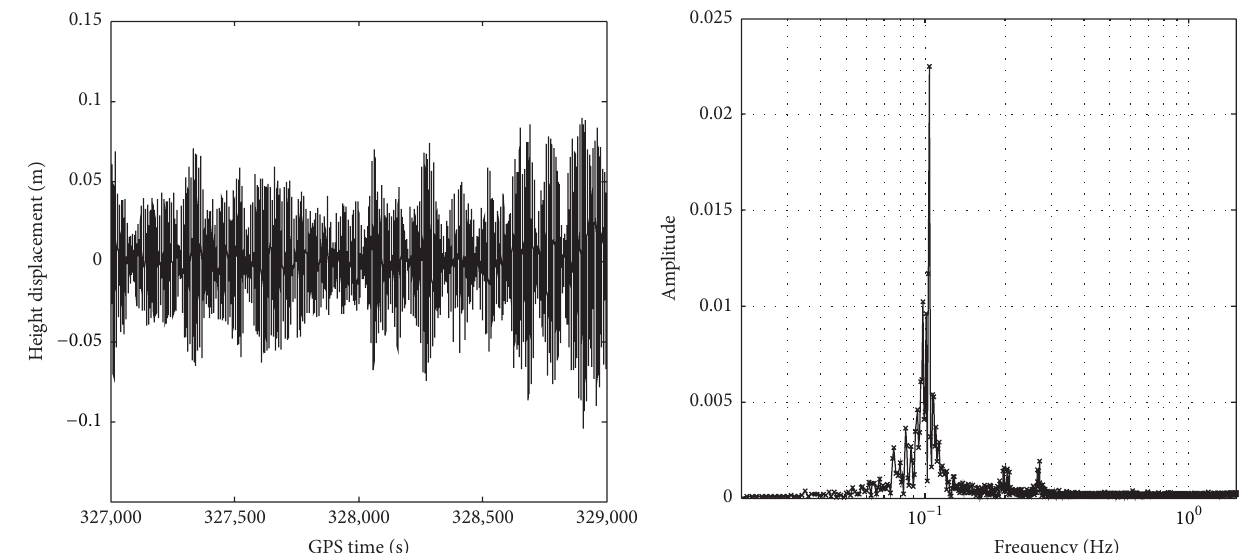
Figure 21: The filtered height displacements and corresponding frequencies during the wind speed increasing period.